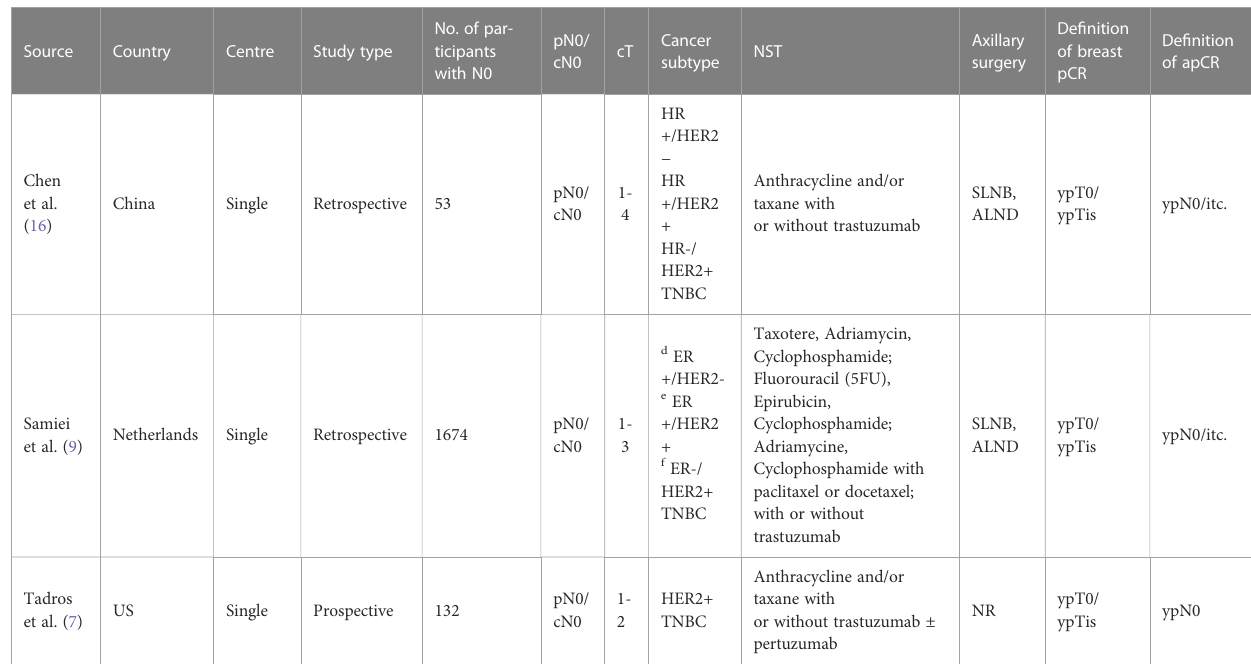
Seven studies (9, 10, 14 – 18) involving 865 cN0 patients with bpCR who had HR+/HER2- breast cancer were published (Figure 2). The overall pooled ypN+ rate was 5.1% (95% CI, 0.7%-11.9%) (42/865 cases). With an I 2 value of 71.41% between the trials, there was signi fi cant heterogeneity (P=0.002). According to three studies (9, 10, 15) (Figure 3), 762 cT1-T2N0 patients who achieved bpCR had a pooled ypN+ rate of 2.7% (95% CI, 0.1%- 7.4%) (29 cases).